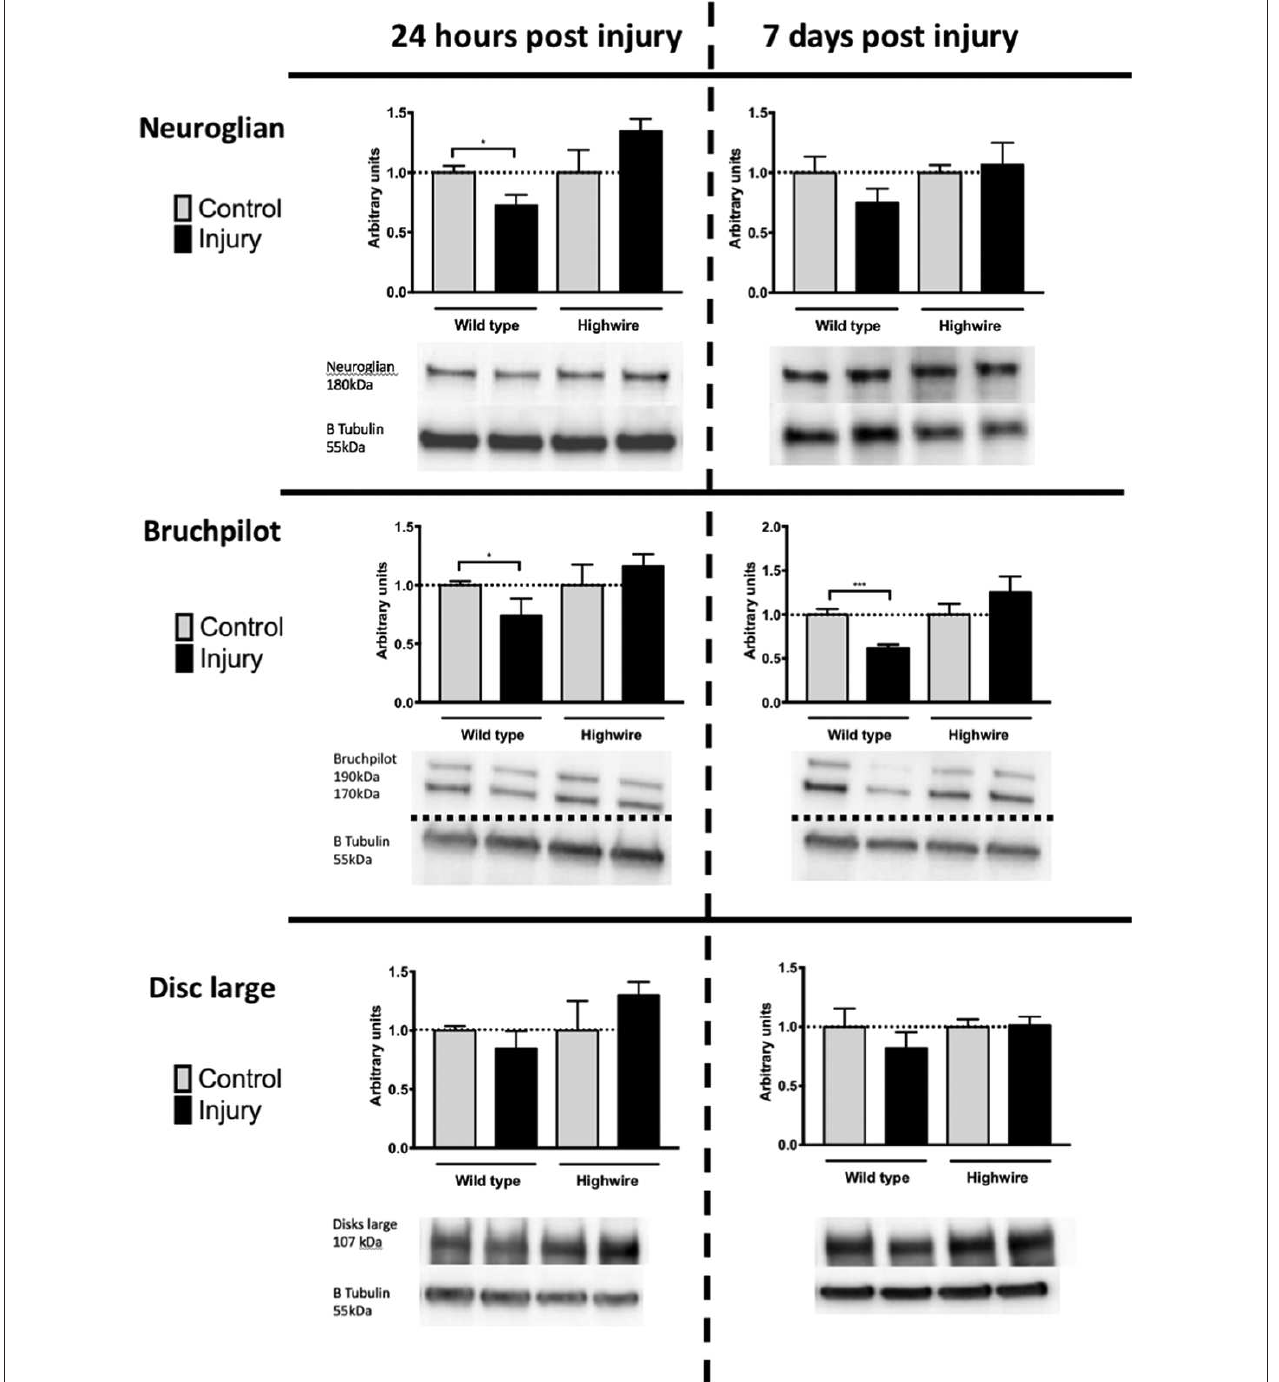
FIGURE 4 | Injured flies demonstrate a loss of presynaptic marker protein that is prevented by highwire mutation. Levels of Neuroglian, Bruchpilot, or Disc large relative to β tubulin loading control at 24h and 7 days following injury in hiw 1 N and hiw WT flies. Representative blots are displayed. n = 5 per condition. Error bars show standard error of the mean. Statistical analysis was with two-way ANOVA test. * p ≤ 0.05, *** p ≤ 0.001.